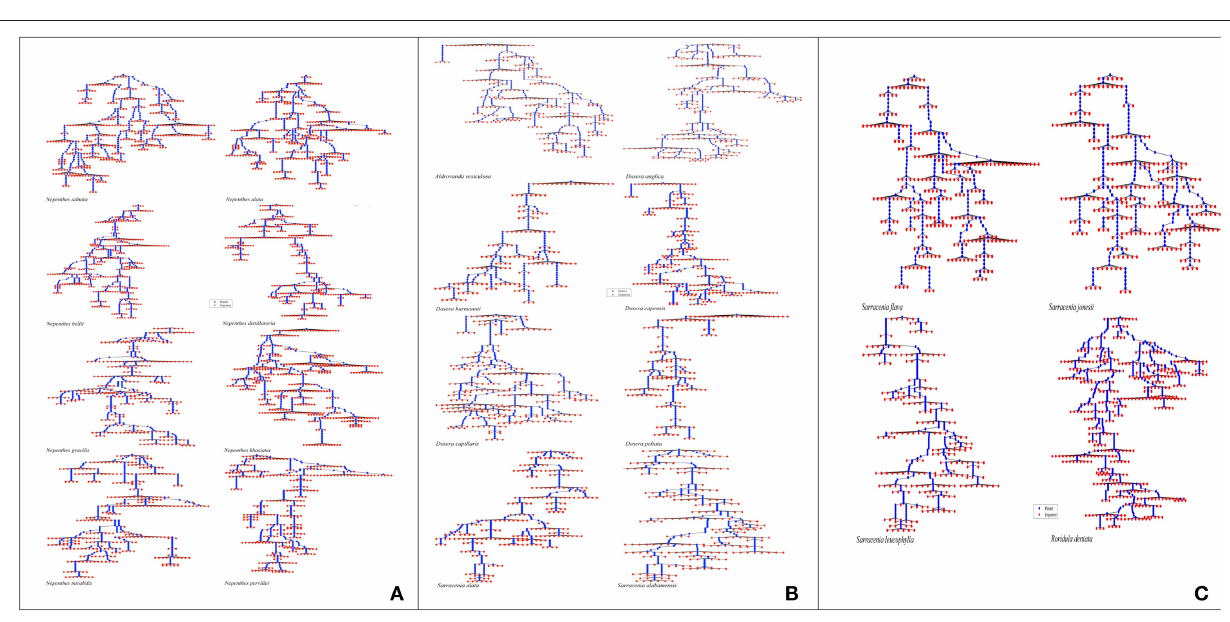
FIGURE 4 | ITS2 secondary structure tree diagrams of species representing carnivorous plant families Nepenthaceae (A) , Droseraceae (B) , Sarraceniaceae and Roridulaceae (C) generated in RNA plot MATLAB